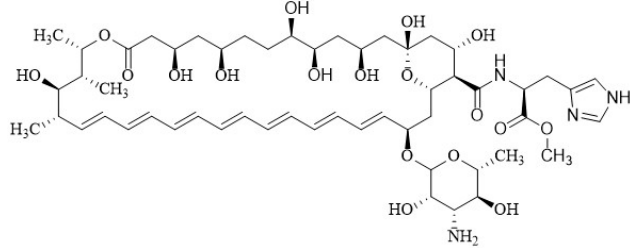
Figure 11. Structure of A21 , an amphotericin B derivative 8 .